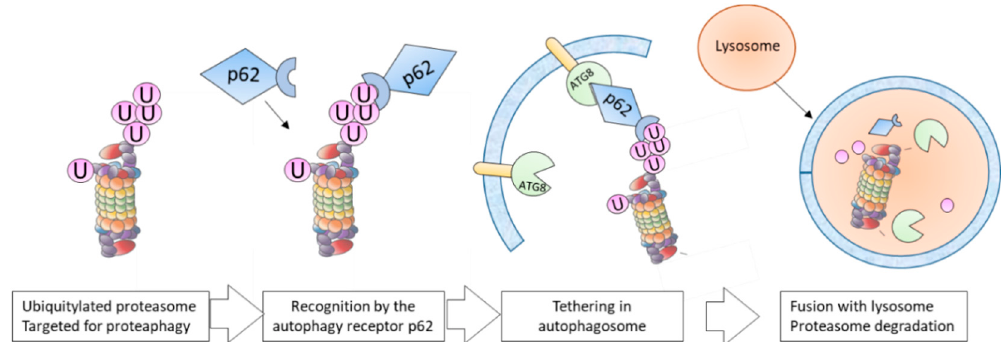
Figure 3. Main steps occurring during proteaphagy. In mammalian cells, ubiquitylated proteasomes are recognized by the autophagy receptor p62 that interacts with lipidated ATG8 proteins tethered into the autophagosome membranes. The late fusion with lysosome ensures the enzymatic degradation of captured proteasomes.